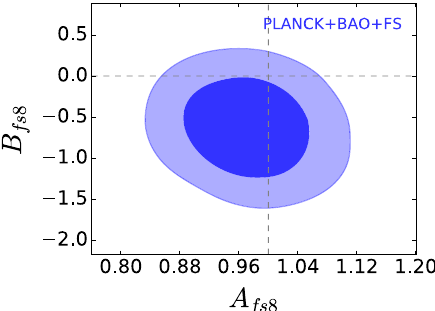
Fig.9 68%and95%confidencecontoursonmodificationofthegrowthfunctioninthe Λ CDMcosmological + B ( z − z p ) ] with a redshift pivot z p = 0 . 51. The results are model using the form f σ 8 → f σ 8 [ A f σ f σ 8 8 = 1, B = 0 (dashed grey lines). As explained consistent with the predictions of general relativity: A f σ f σ 8 8 in the text, the analysis used temperature and polarization data from Planck 2015, and a set of consensus values for BAO and RSD using full shape measurements (FS) from SDSS DR12. Figure reproduced with permission from Alam et al.